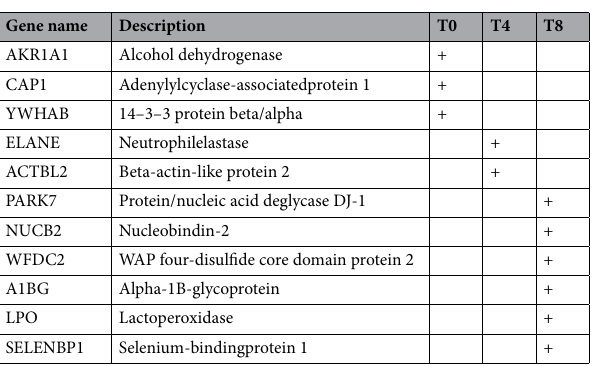
Table 1. Unique proteins identified in the three different clinical conditions: at baseline (T0), after 4 (T4) and 8 weeks (T8) of treatment with rhNGF